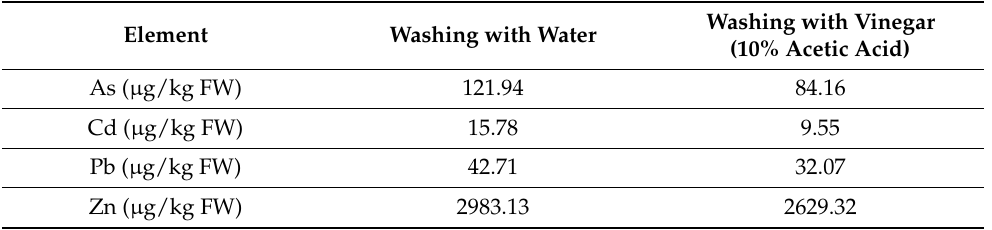
Figure 2. Differences between heavy metal concentrations in samples of fruit and vegetables washed with tap water and vinegar (10% acetic acid). Regarding the efficiency of the vinegar, small differences were observed between the 5% and 10% vinegar results (Table 6; Figure 3).